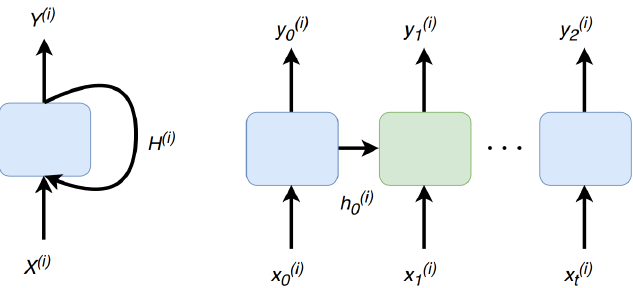
( i ) , that along the previous output t